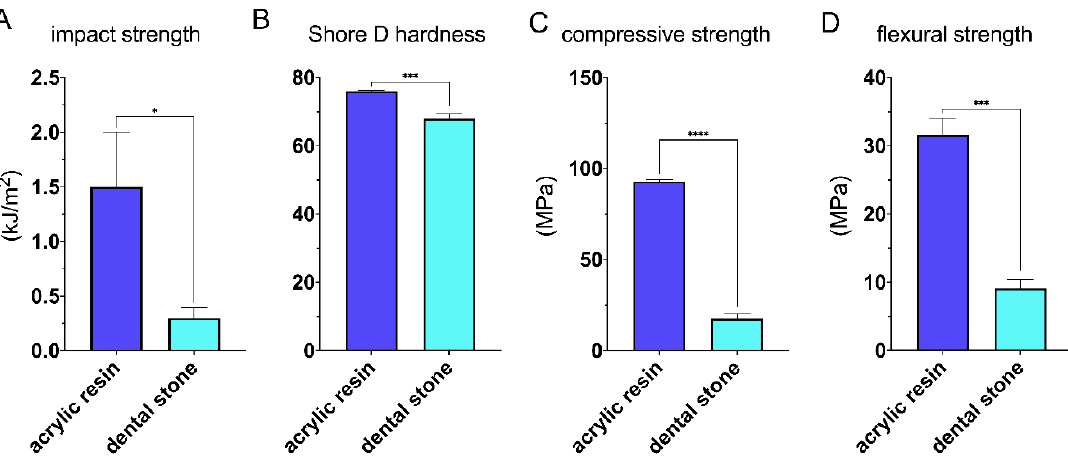
Figure 4. Mechanical properties of acrylic and plaster samples: ( A ) impact strength, ( B ) Shore D hardness, ( C ) compressive strength, and ( D ) flexural strength.